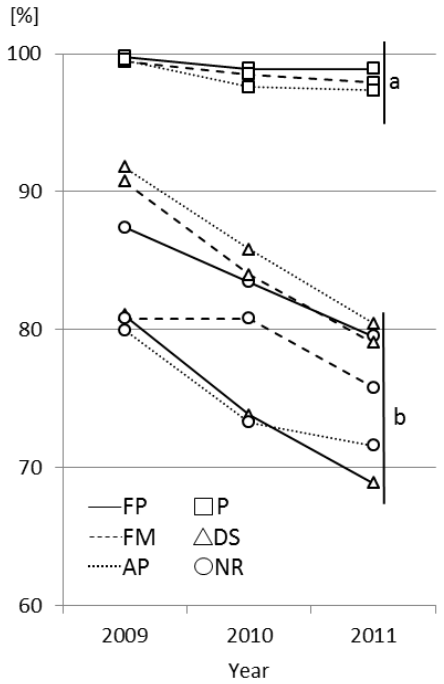
Figure 4. Mean survival (%) of Scots pine seedlings during 3 years for three reforestation methods (planting (P); direct seeding (DS); natural regeneration (NR)) and three mechanical site preparation methods (forest plough (FP); forest mill (FM); active plough (AP)). Different letters indicate significant differences in the Kruskal–Wallis test, p ≤ 0.05.